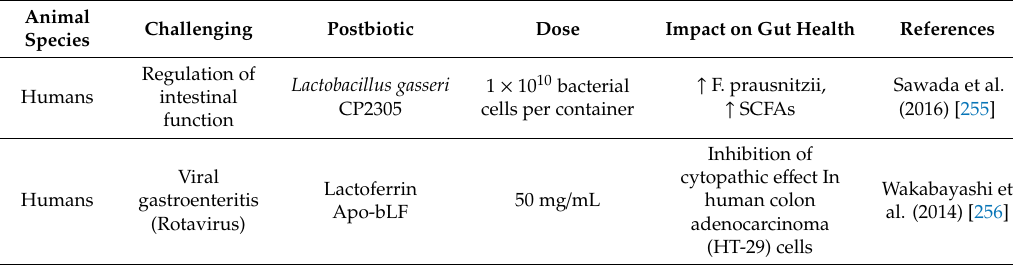
Table 3. Impact of postbiotics on gastrointestinal health: main experimental